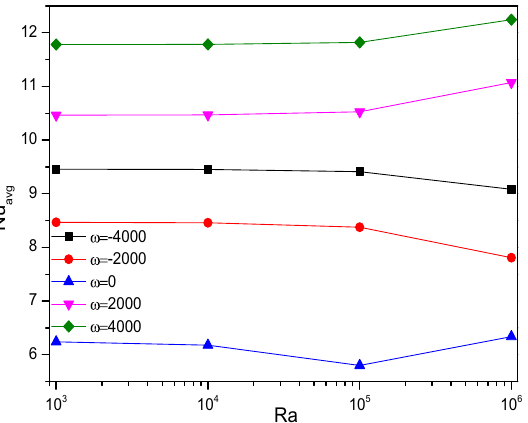
Figure 8. Variations of Nu avg with Ra for diverse ω when Da = 0.01 , φ = 0.02 , Ha = 0 , N = 4 , r = 0.1, and ε = 0.2 .